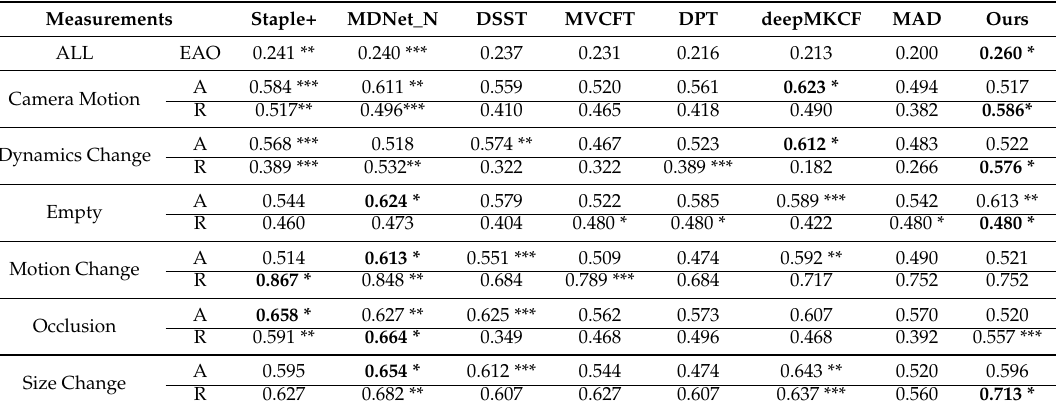
Table 1. Quantitative results of expected average overlap (EAO), Accuracy (A) and Robustness (R) of the eight best trackers. The best, second best and the third best trackers in different situations are marked by */**/***,